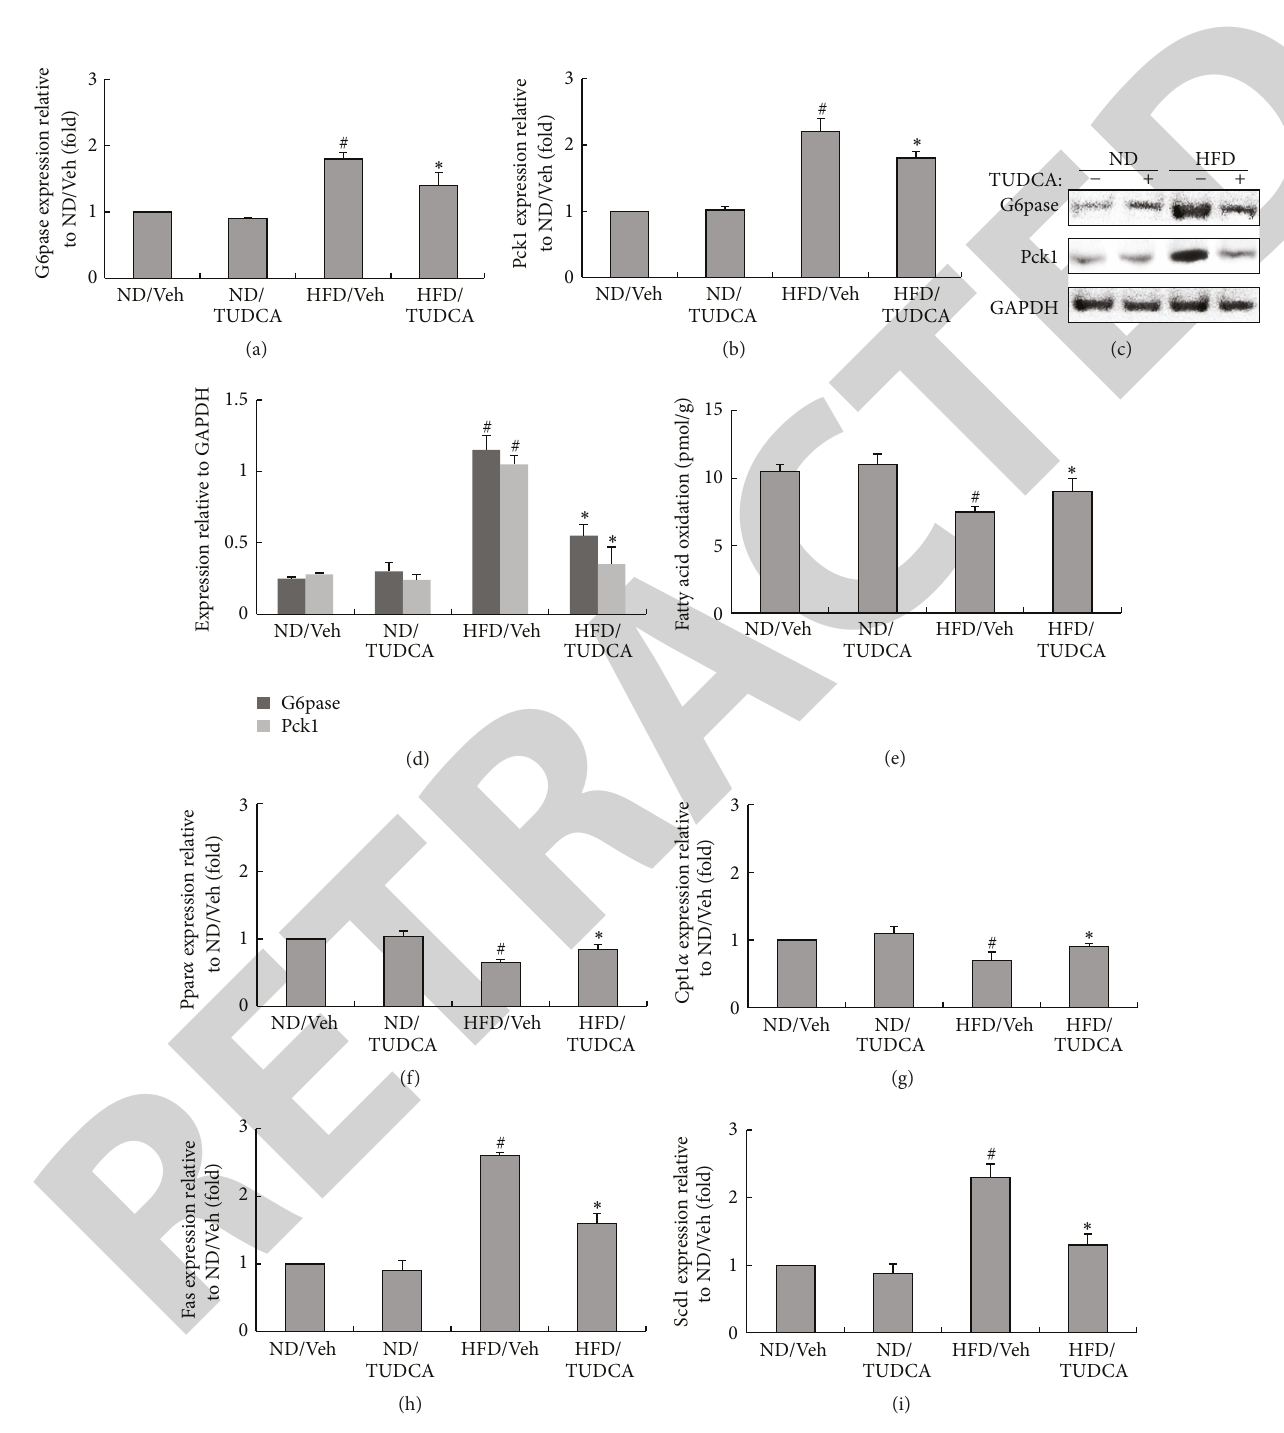
Figure 3: Effects of TUDCA on hepatic glucose and lipid metabolism in vivo . All analyses were performed in mice fed a normal diet (ND) or a high-fat diet (HFD) for 8 weeks and then injected daily with 500 mg/kg of TUDCA or with vehicle (Veh) for 8 weeks. (a) Relative expression of G6pase in liver (real-time PCR). (b) Relative expression of Pck1 in liver (real-time PCR). (c) Protein expression of G6pase and Pck1 in liver. (d) The relative protein quantity of G6pase and Pck1 in liver. (e) Fatty acid oxidation (pmol/g). (f) Relative expression of Ppar 𝛼 in liver (real-time PCR). (g) Relative expression of Cpt1 𝛼 in liver (real-time PCR). (h) Relative expression of Fas in liver (real-time PCR). (i) Relative expression of Scd1 in liver (real-time PCR). The relative quantity of proteins was analyzed using Quantity One software. A representative blot is shown and the data was expressed as mean ± SEM in each bar graph. ∗ 𝑃 < 0.05 (HFD/TUDCA versus HFD/Veh). # 𝑃 < 0.05 (HFD/Veh versus